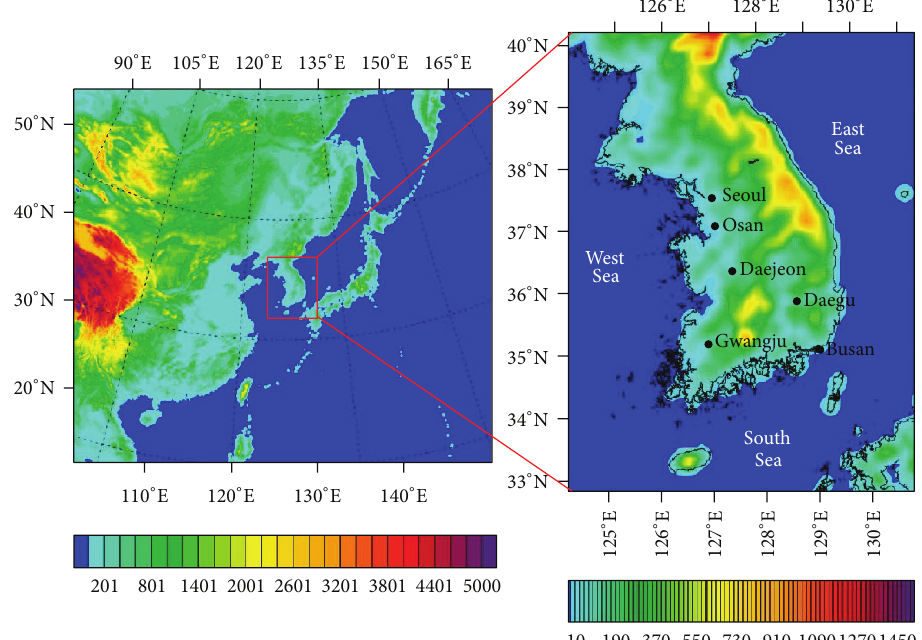
Figure 2: Topography used in the KWRF. Geographic locations of representative large cities are shown together with two operational radiosonde sites, Osan and Gwangju. The West Sea, the East Sea (also known as Sea of Japan), and the South Sea are located west, east, and south of the Korean Peninsula. Contour intervals are indicated at the